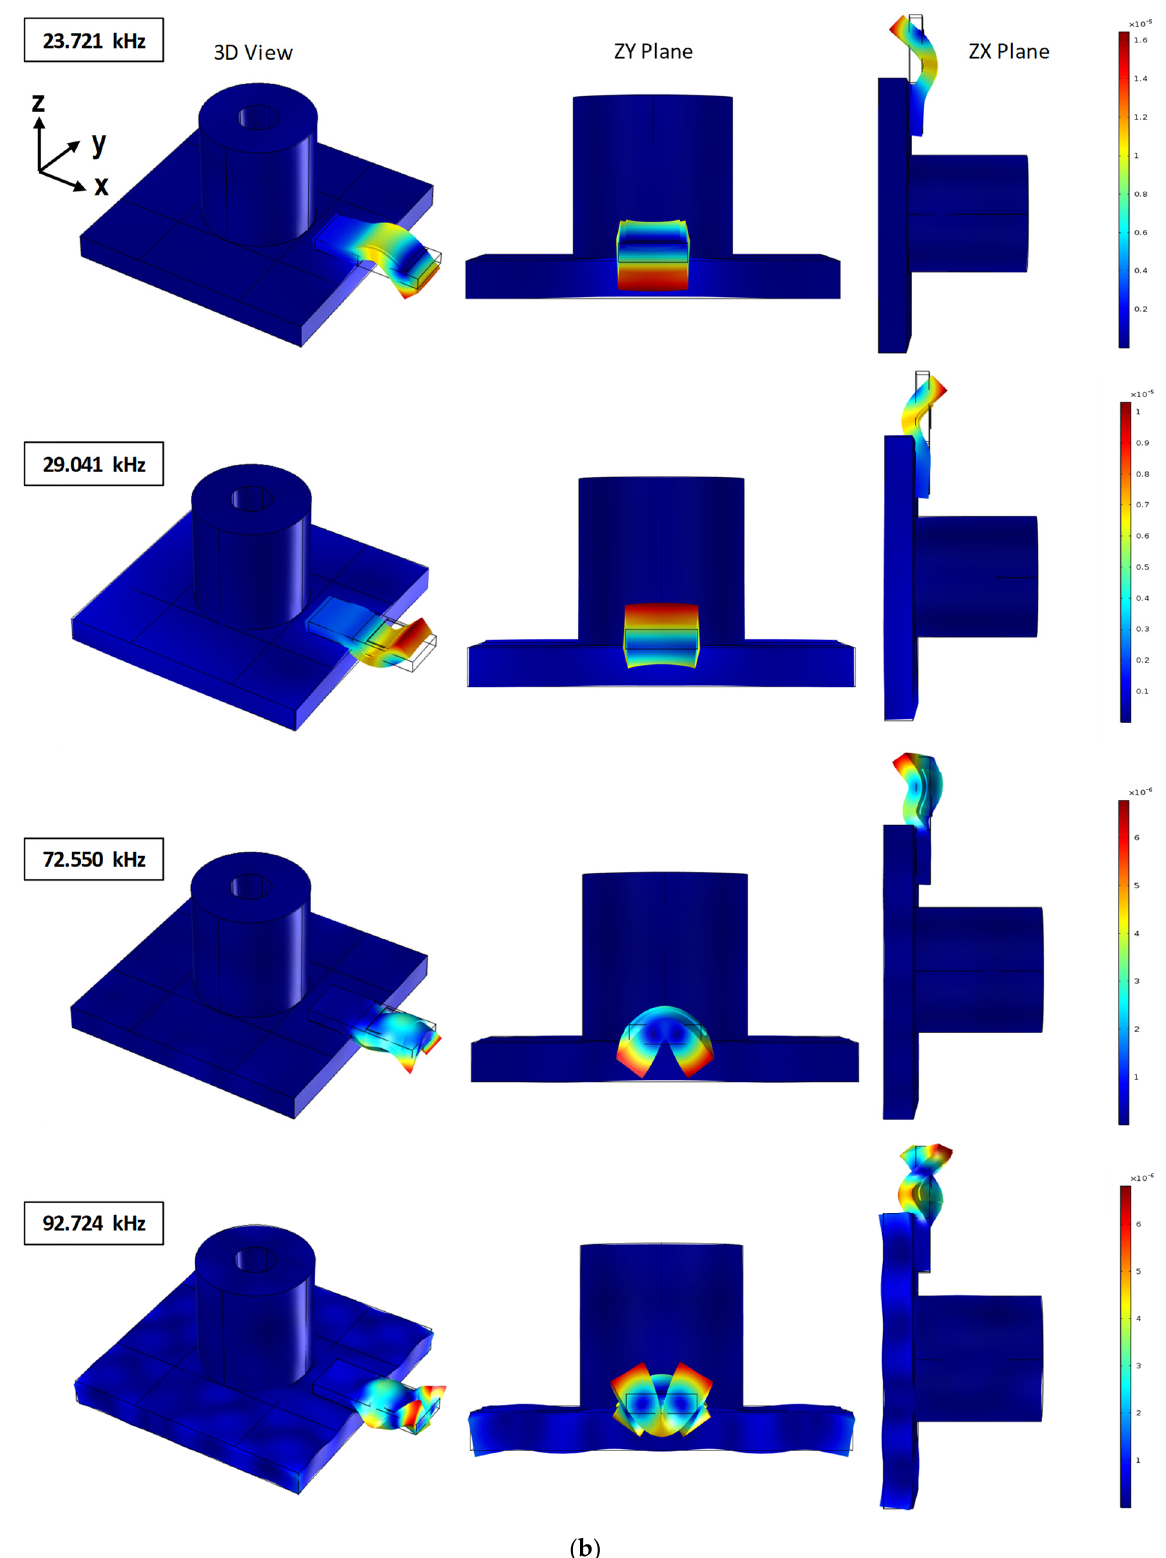
Figure 7. Identified modal parameters corresponding to resonant impedance peaks of the PZT interface-anchorage system. ( a ) Identified modes for the resonant impedance peaks; ( b ) 3-dimensional modal shapes of the identified modes. The frequency and 3-dimensional modal shapes of the identified modes are